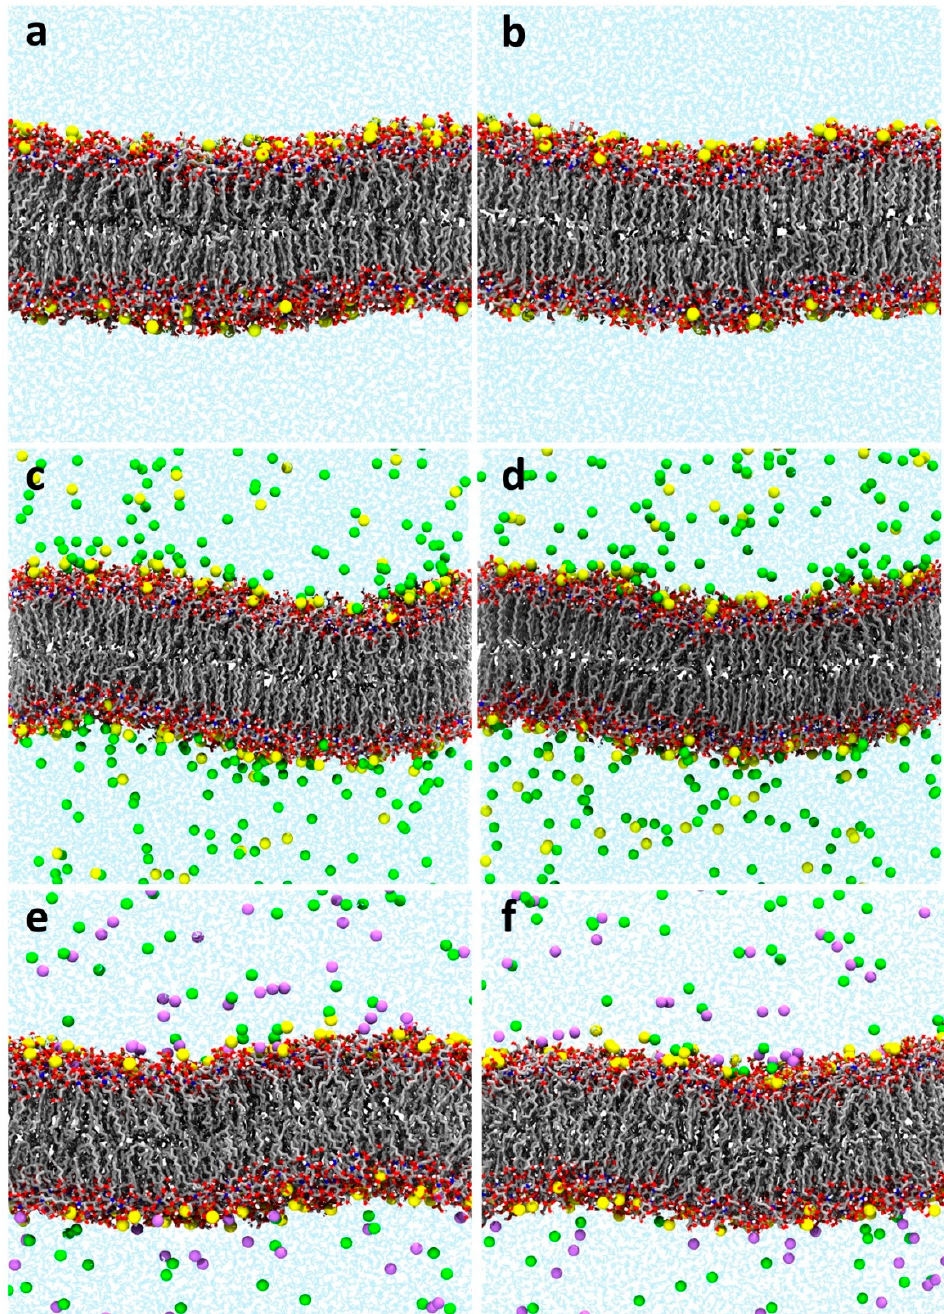
Figure 4. Representative conformations from MD simulations of lipid-A membranes in the presence of Al 3 + counterions using the stepwise-thermalization NVT / NPT protocol and two long-range electrostatic approximations. Lipid-A bilayers without ( a , b ) addition of salts, ( c , d ) with addition of 150 mM of AlCl 3 , and ( e , f ) with addition of 150 mM NaCl. Long-range electrostatic interactions were approximated using reaction-field (first column) or particle-mesh Ewald (second column). Simulations were run in duplicate for 400 ns after the equilibration phase with the stepwise thermalization protocol. Al 3 + , Na + , and Cl − are shown in yellow, magenta, and green van der Waals spheres, respectively.